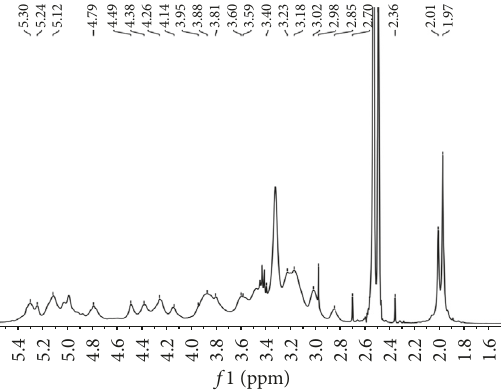
Figure 4: 1 H NMR spectrum of hemicellulosic fraction H 50 .